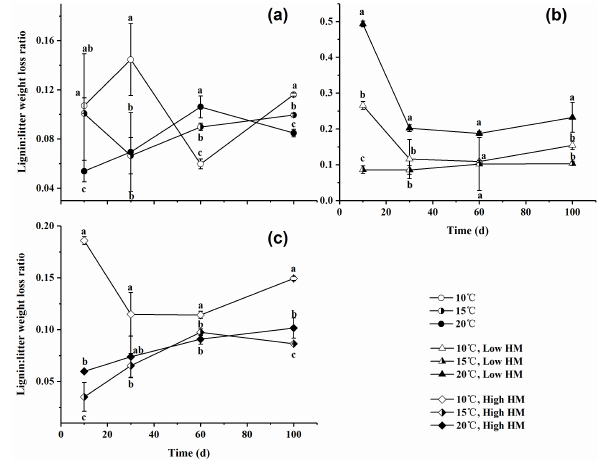
Figure 3 : Changes in chemistry characters of lignin: litter weight loss ratio (L/W) in Typha incubated at three temperatures and two heavy metal (HM) levels. Legend: (a) control treatment; (b) three temperatures and low heavy metal levels; (c) three temperatures and high heavy metal levels. Different lowercase letters on the top of the bars denote significant differences among different treatments at the same sampling time (n=3, P < 0.05).